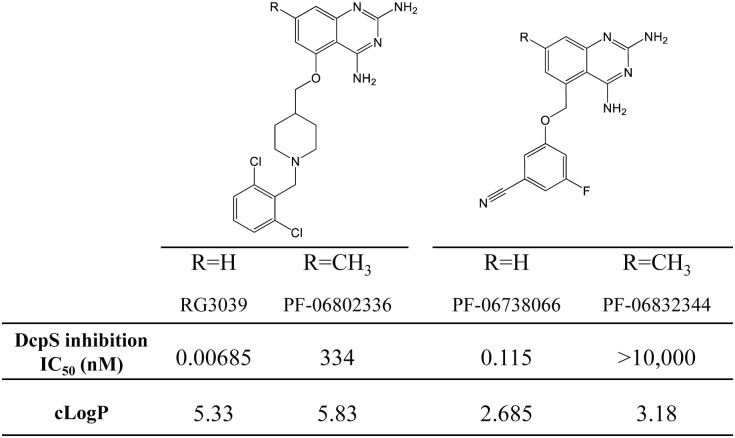
The chemical structures of C-5-substituted 2,4-diaminoquinazoline DcpS inhibitors used in this study.The active DAQ-DcpSi compounds are RG3039 and PF-06738066 and their inactive 7-methyl analogues are PF-06802336 and PF-0683234, respectively. DcpS inhibition activity (IC50) and cLogP for each compound are provided. Values represent the mean of two or more independent assays.